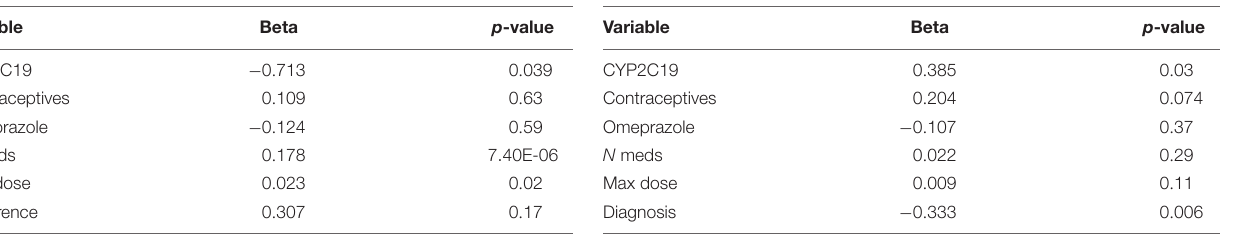
TABLE 7 | Multivariate model of activation side effects. TABLE 8 | Multivariate model of response.